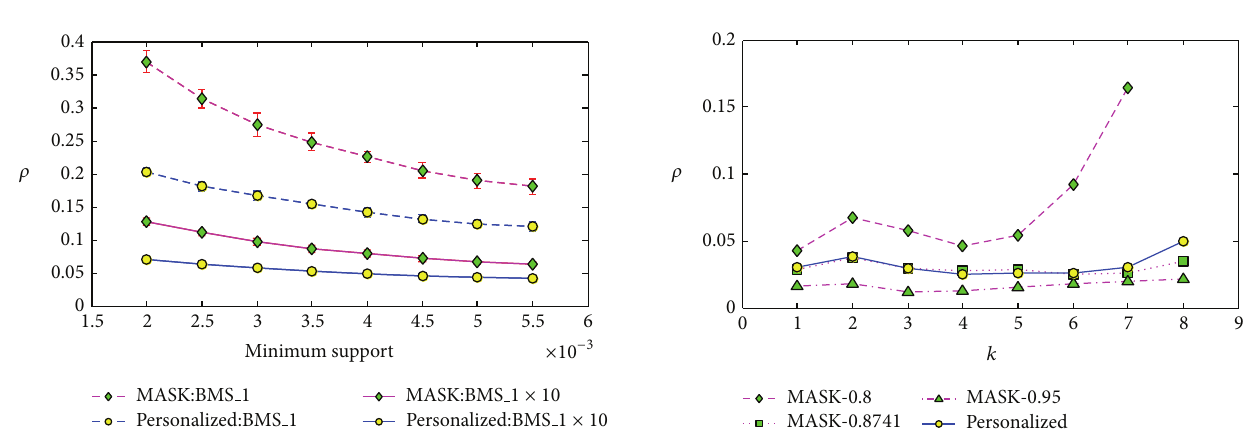
Figure 13: Support error 𝜌 versus itemset length 𝑘 on dataset T40.I10.D100K.N942.